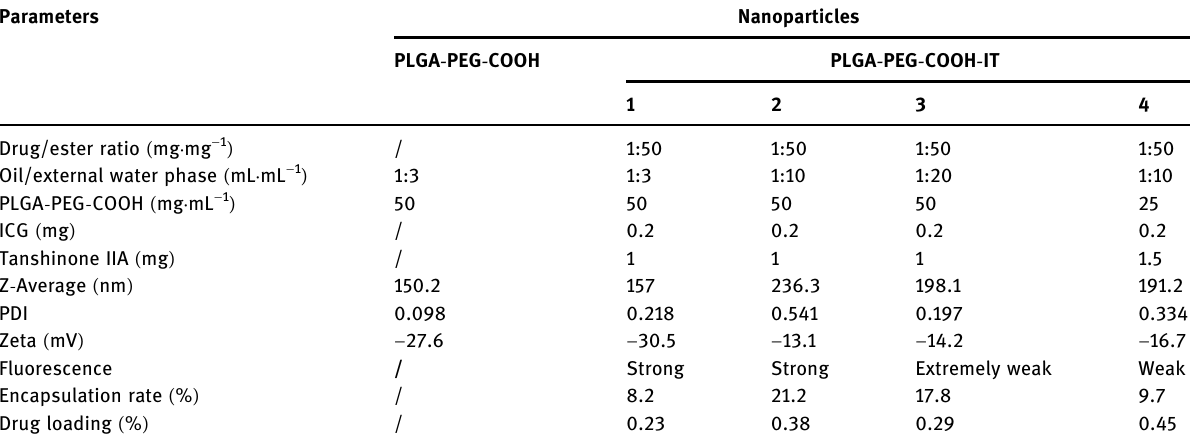
Table 1: Size, zeta - potential, fl uorescence, and drug loading characteristics of the nanoparticles at di ff erent preparation parameters